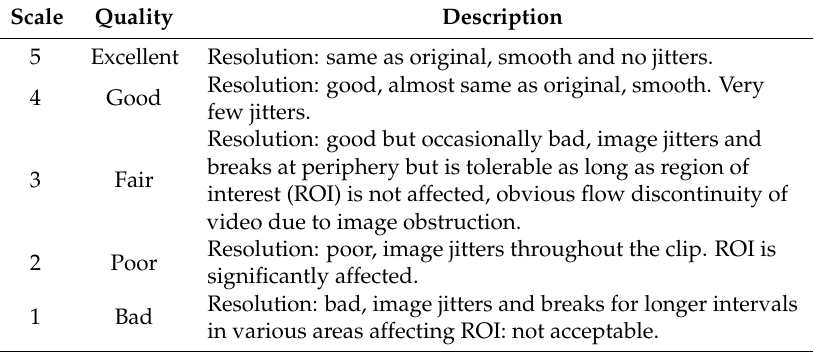
Table 4. Mean opinion score (MOS) for subjective video quality